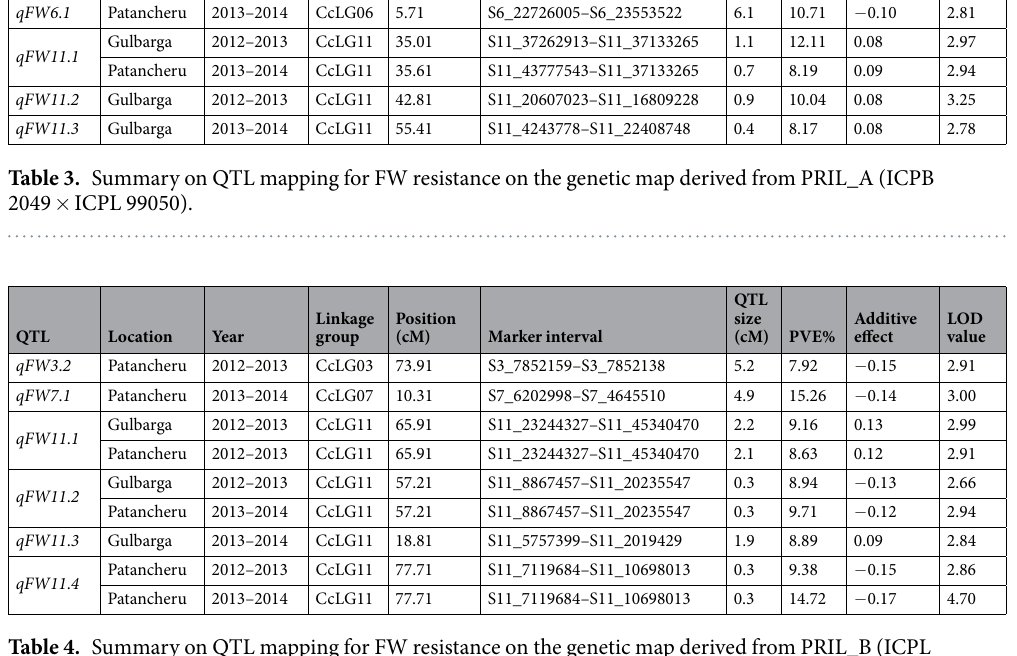
Table 4. Summary on QTL mapping for FW resistance on the genetic map derived from PRIL_B (ICPL 20096 × ICPL